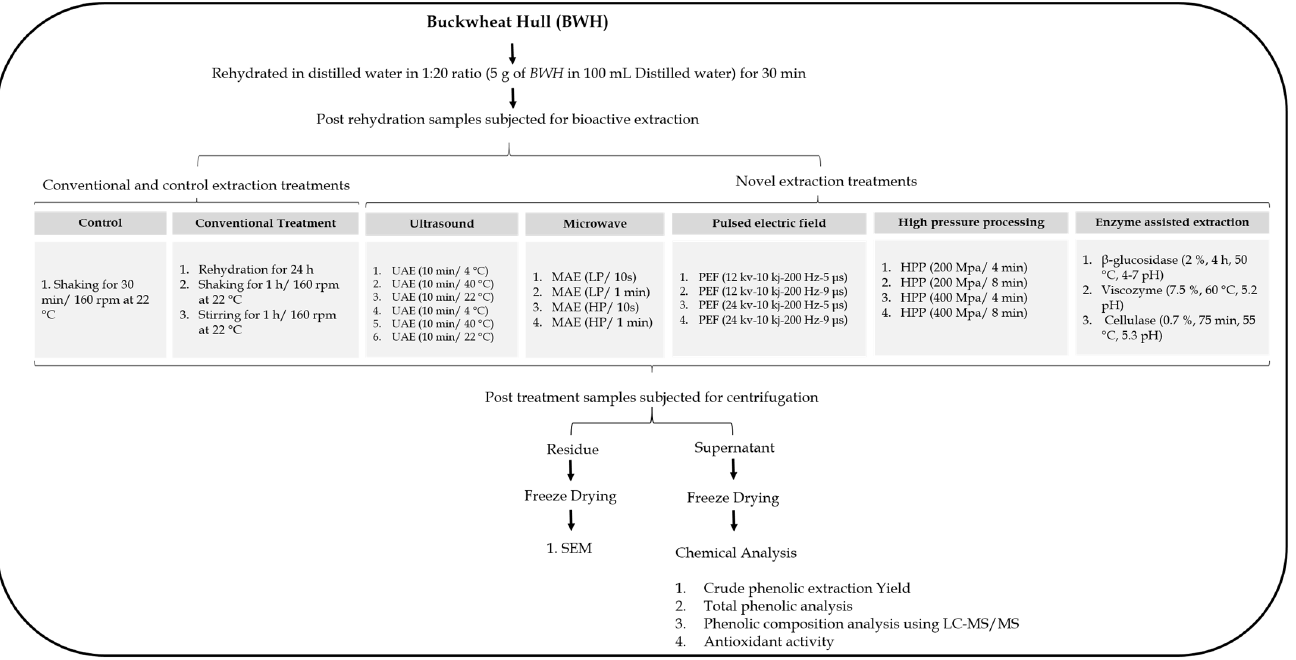
Figure 1. Schematic workflow of the bioactive extraction protocols employed to obtain phenolic extracts from buckwheat hull.